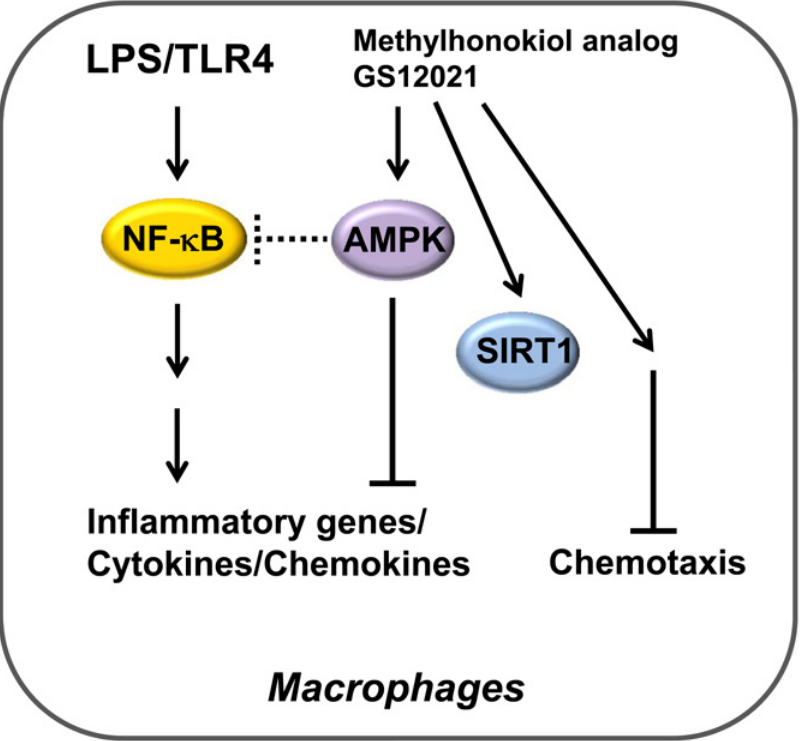
Fig 10. Graphical abstract shows that AMPK is required for GS12021 inhibition of inflammation by but not for its inhibition of chemotaxis in macrophages.